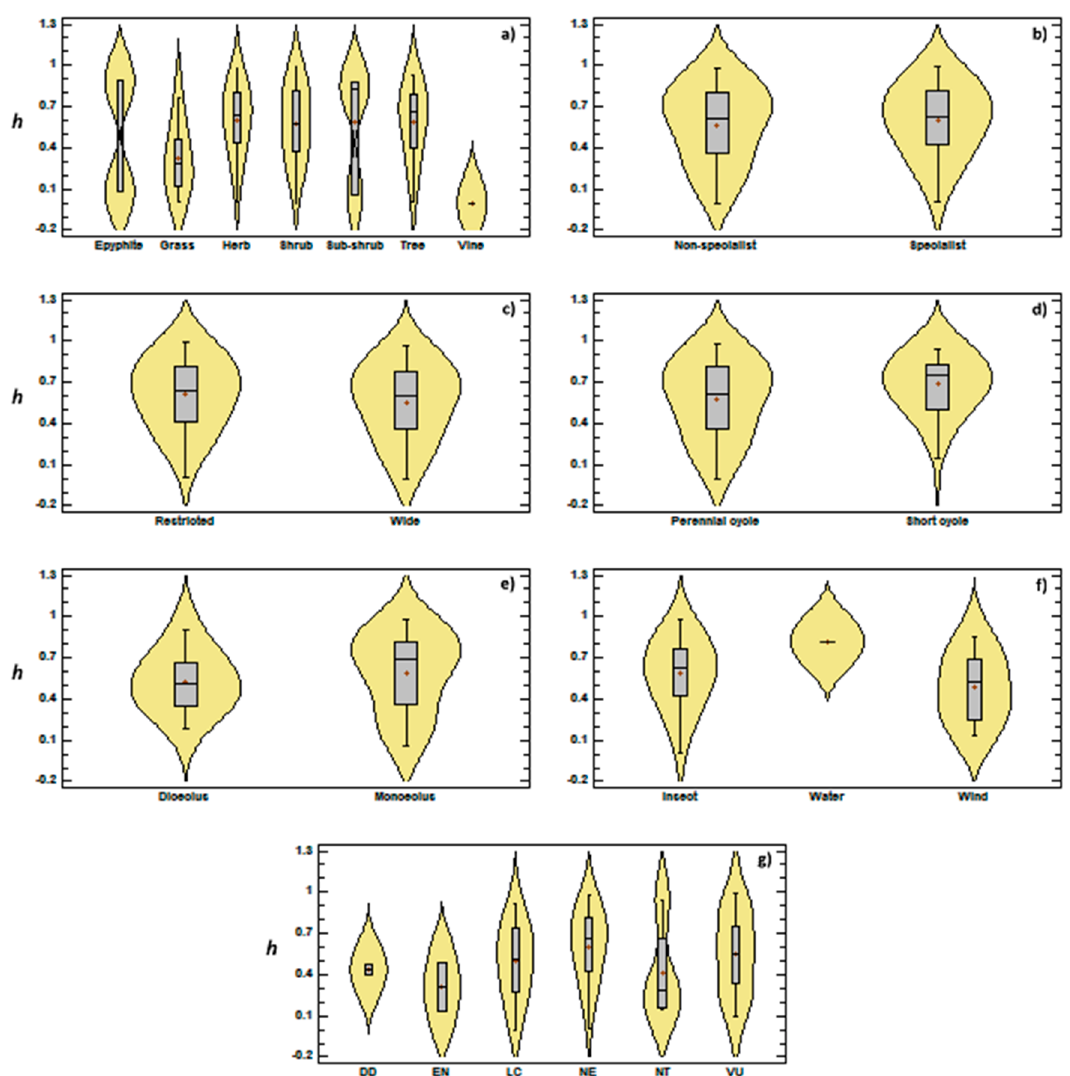
Figure 7. Mean haplotype diversity ( h ) observed in the different angiosperm groups targeted in studies that used chloroplast markers: ( a ) life mode; ( b ) habitat specialist / non-specialist; ( c ) geographic distribution; ( d ) reproductive cycle; ( e ) type of flower; ( f ) type of pollinator, and ( g ) IUCN category. + = average.